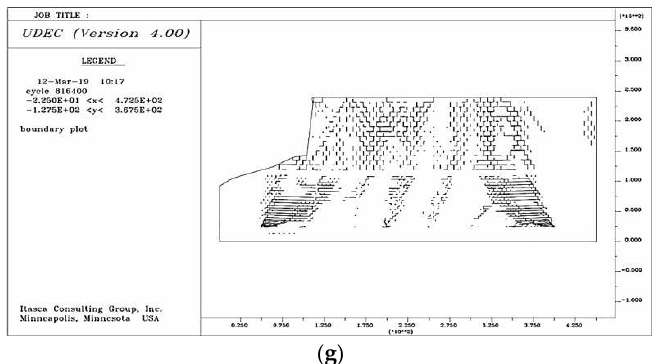
Figure 6. Coal seam mining effect diagram: ( a ) 50 m forward; ( b ) 100 m forward; ( c ) 150 m forward. ( d ) 200 m forward: separated fissure and surface penetration; ( e ) 250 m forward; ( f ) 300 m forward: the whole crack is close to the perilous rock; ( g ) 350 m forward: fracture and surface penetration of perilous rock.